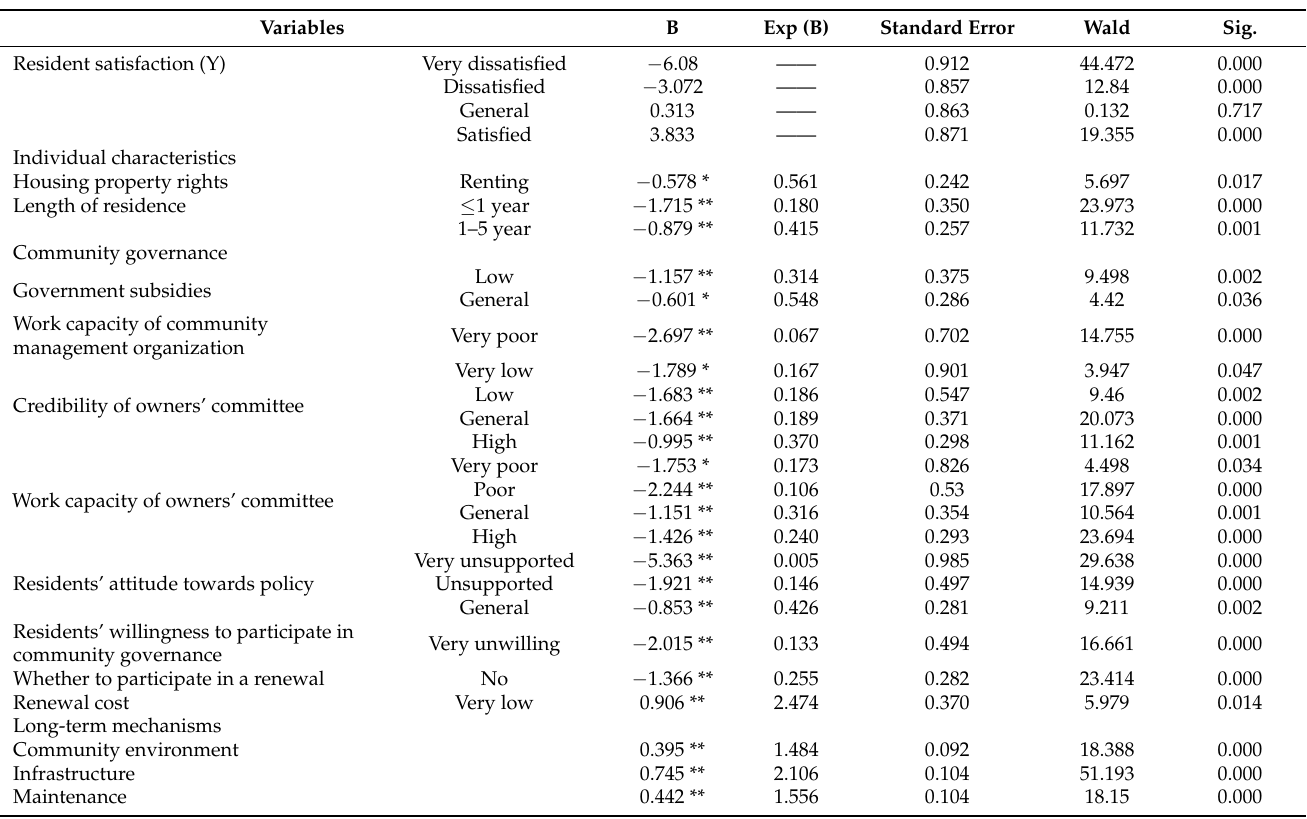
Table 5. Results of ordinal logistic